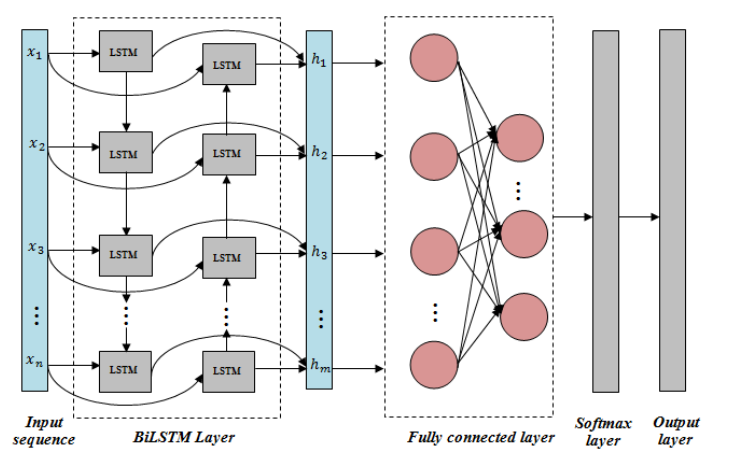
Figure 3. BiLSTM architecture for fault